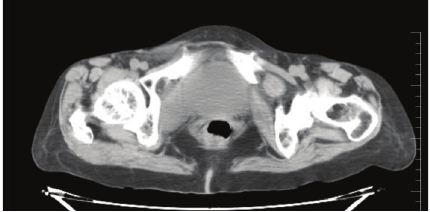
Figure 3: CT scan of lower pelvis and inguinal region showing her- niation of small bowel loop through left obturator canal extending between pectineus and obturator internus muscles.